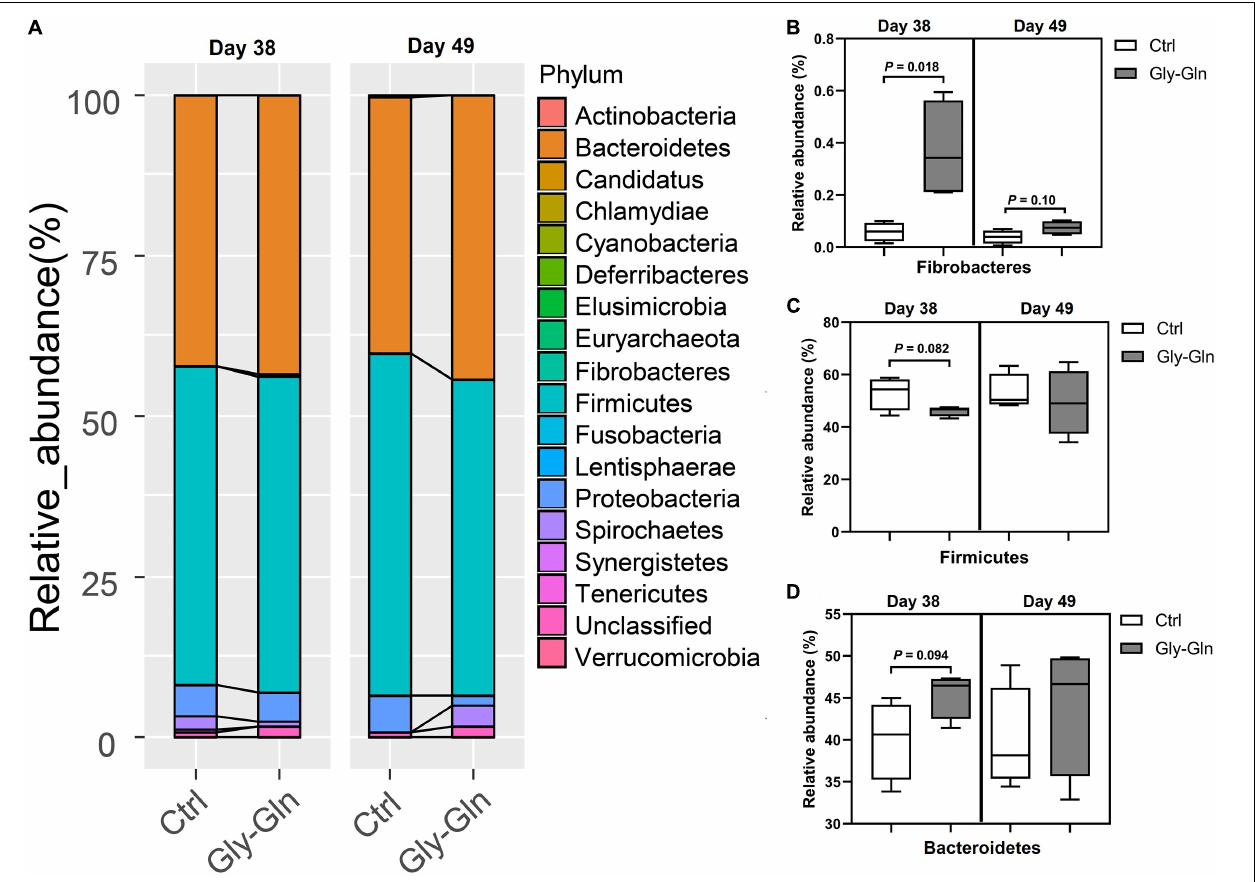
FIGURE 4 | Effect of dietary Gly-Gln supplementation on the relative abundance of gut microbiota at phylum level. (A) The relative abundance of gut microbiota at phylum-level on day 38 and day 49 respectively. The relative abundance change of Fibrobacteres (B) , Firmicutes (C) , and Bacteroidetes (D) in gut microbiota. The values are expressed as means ± SEM, n =